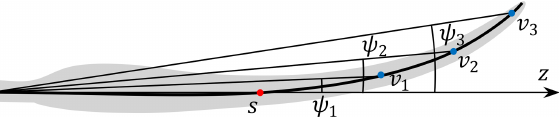
Figure 4. Illustration of the variation of the range of the sweep angle ψ with the increase of the relative position ˆ h for a swept blade. The calculation point s is further inboard compared to the trailing point and is not changed. When the trailing point is changing from v 1 to v 2 and then to v 3 , the value of ˆ h and the sweep angle ψ are